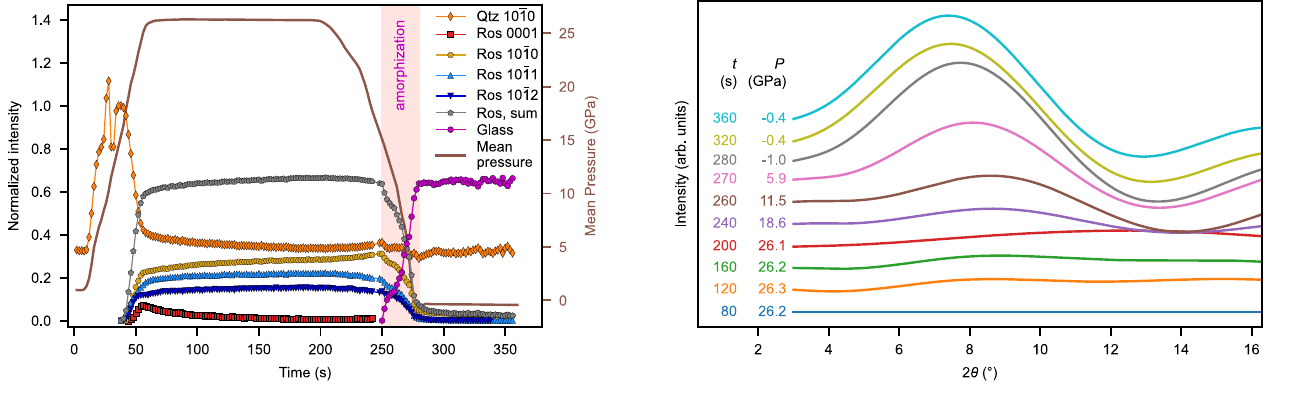
Fig.3|StackedrelativeX-raydiffractionintensitiesofbackgroundsforvarious Fig. 2 | Variation of the normalized X-ray diffraction intensities of the main -- times ( t ) and pressures ( P ) during loading (80 – 200s) and unloading 10 10 peak of quartz (Qtz) and of the additional diffraction peaks of the high- (200 – 360s). The intensities display the difference of each background with pressure silica phase (Ros) at the approximate interplanar spacings of 4.2 -- -- -- (0001), 3.7 ð 10 10 Þ , 2.7 ð 10 11 Þ , and 1.7Å ð 10 12 Þ . The plot additionally shows the respecttothereferencebackgroundat80s.Itisvisiblethatthediffusebackground intensity in the low 2 θ region progressively increases due to the formation of normalizedsumofpeakintensitiesforthehigh-pressurephaseandthenormalized amorphous material. diffuse background intensities, representing the glass